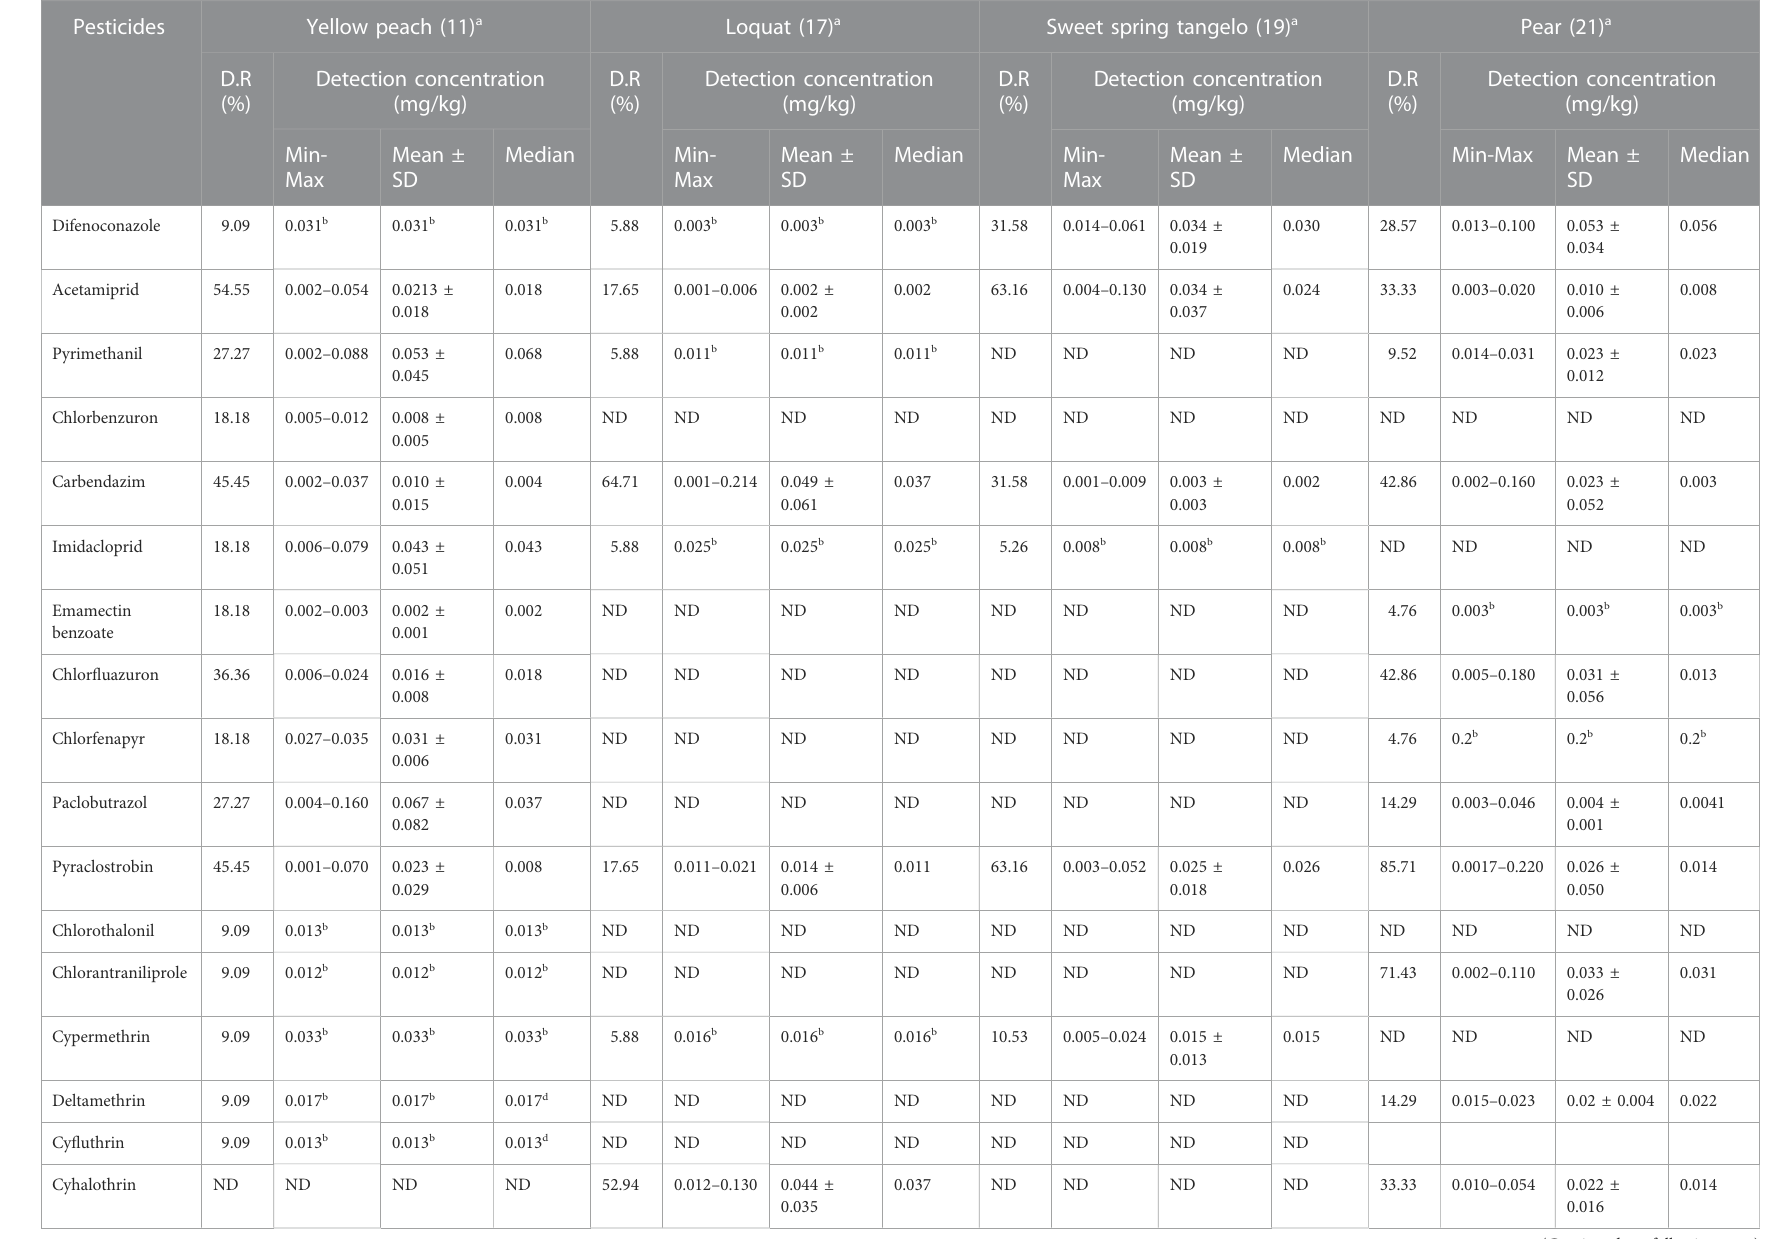
TABLE 1 Frequencies and detection concentrations of pesticides in yellow peach, loquat, sweet spring tangelo and pear